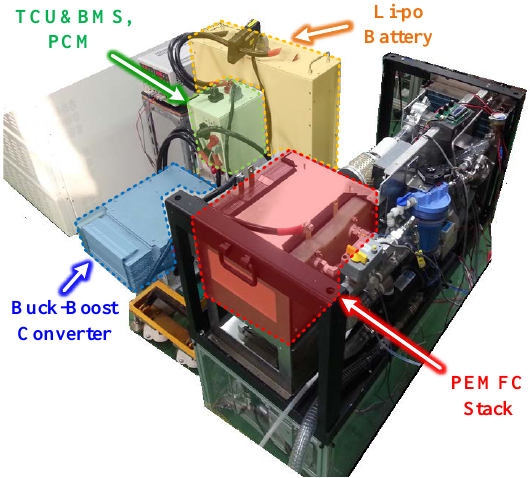
Figure 14. Experiment hardware configuration of hybrid fuel cell battery system.